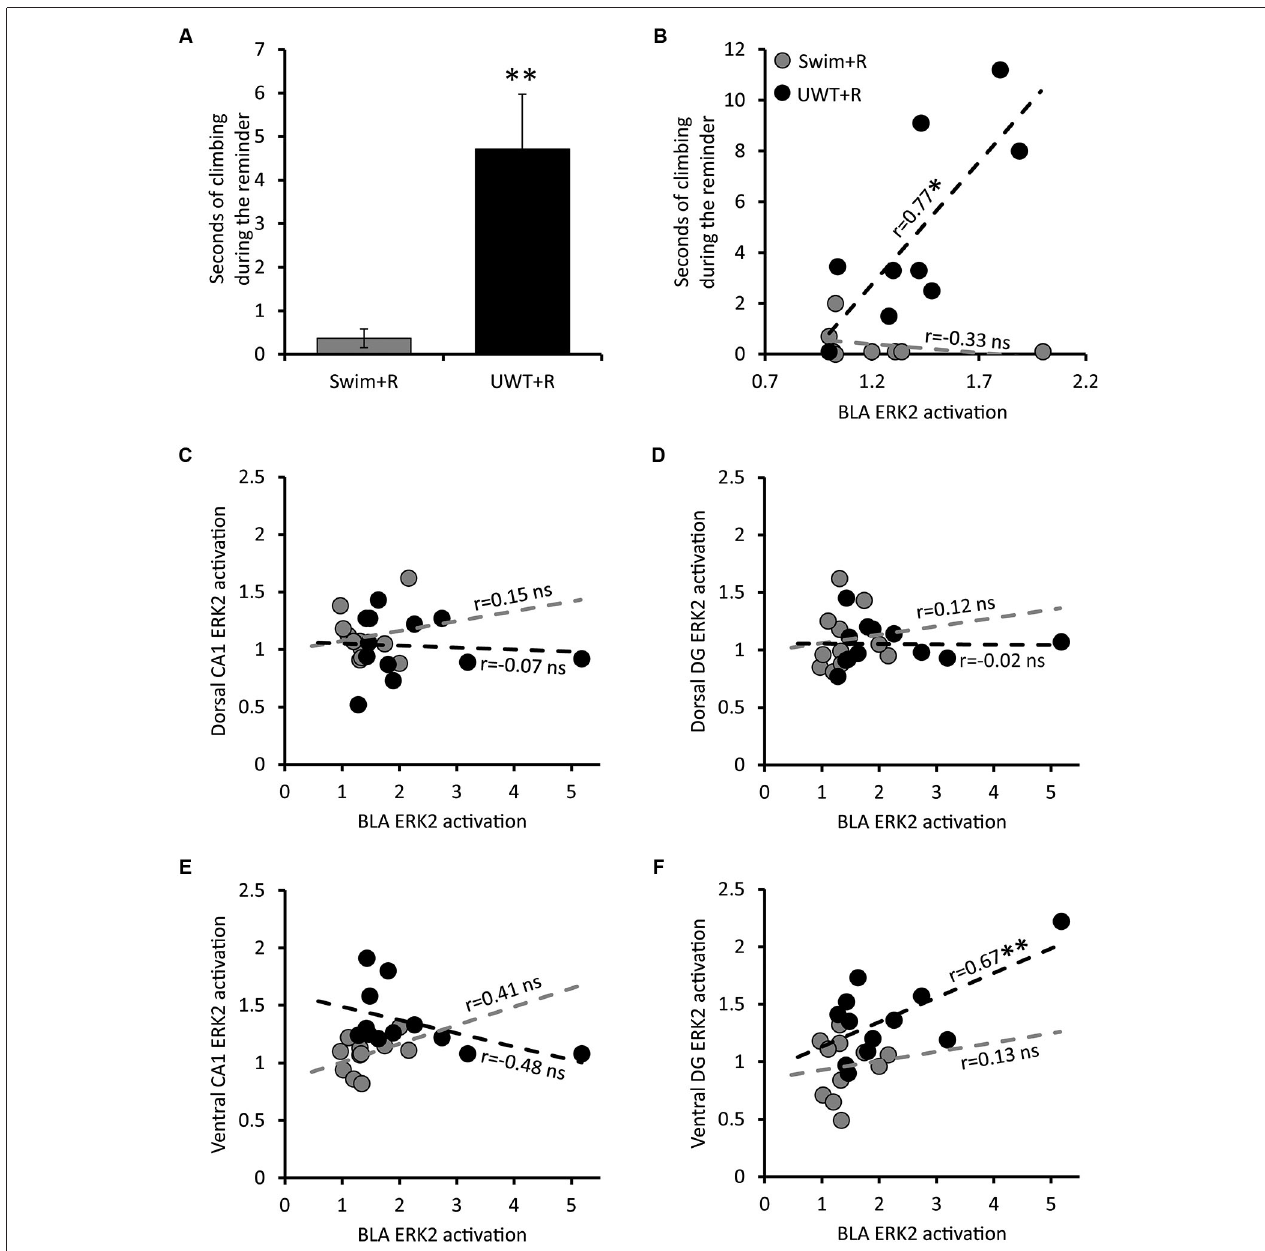
group). (D) Correlation between ERK2 activation in the BLA and ERK2 activation in the dorsal DG ( n = 12 in each group). (E) Correlation between ERK2 activation in the BLA and ERK2 activation in the ventral CA1 ( n = 12 in each group). (F) Correlation between ERK2 activation in the BLA and ERK2 activation in the ventral DG ( n = 12 in each group). * p < 0.05; ** p < 0.01.